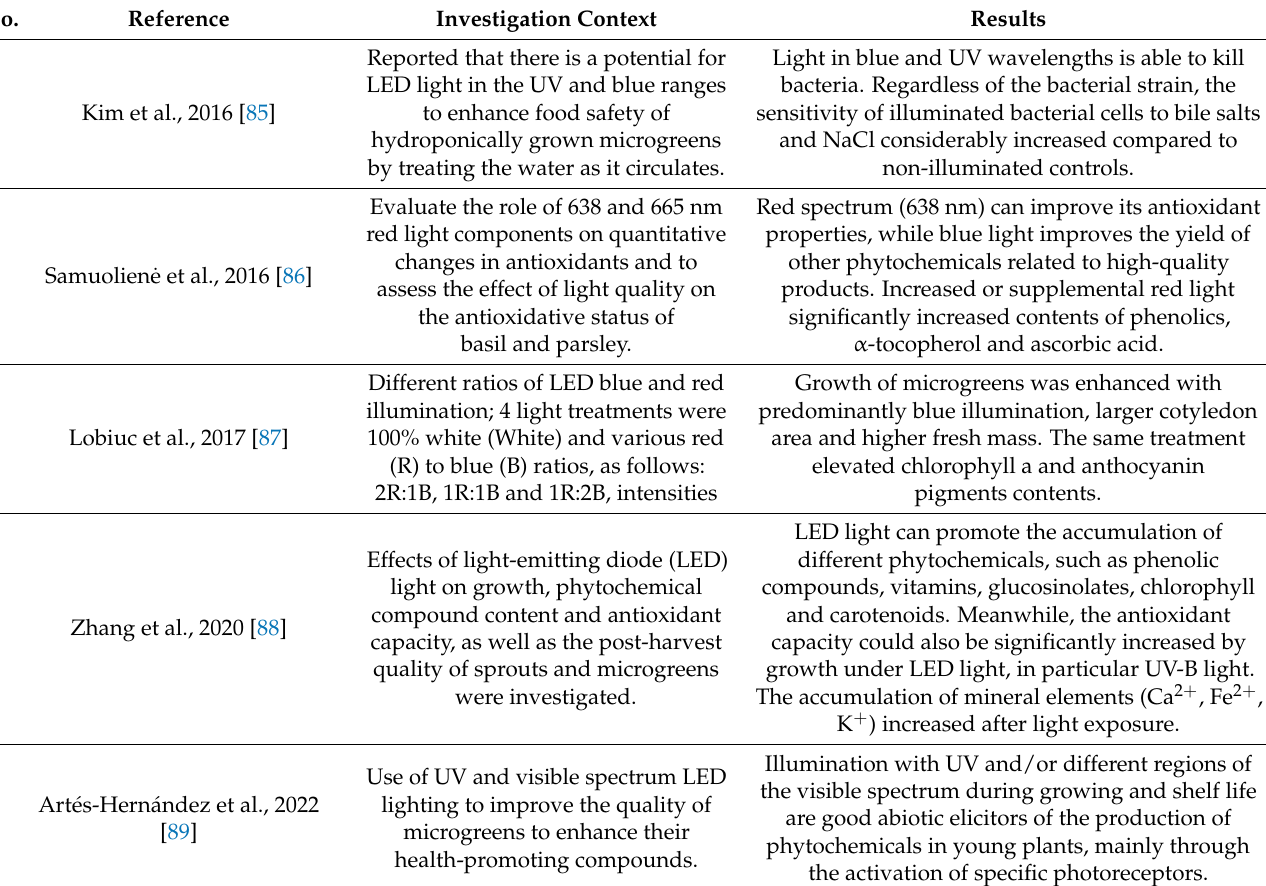
Table 5. Studies showing the possibility of influencing the quality and quantity of microgreens with the help of artificial lighting